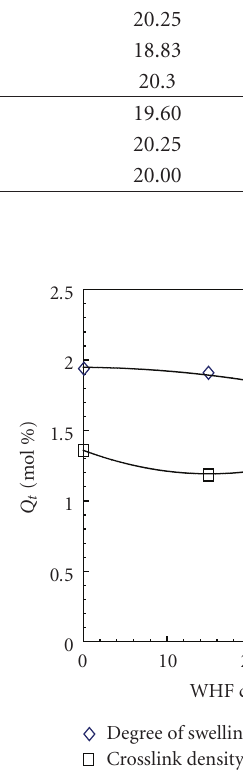
Figure 3: Variation of the degree of swelling and crosslinking den- sity as a function of WHF concentrations filled EPDM